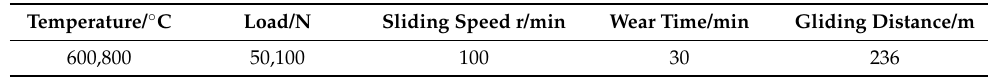
Figure 1. Schematic diagram of the set-up of the oxidation wear experiment. After testing, the samples were polished, subjected to pre-sliding friction for 5 min to ensure the close fit of the friction surface, and then placed in alcohol for ultrasonic cleaning treatment. After drying, the original mean weight m 0 was collected by the average value taken from the 12-time accurate measurement using an electron balance, and the actual volume V 0 of the pre-sliding sample was also obtained by the drainage method [40]. There- after, the pre-sliding pin and disc samples mentioned above were carefully installed on the wear tester for the oxidation wear tests. After the tests, the weight change m 1 was rec- orded to obtain the weight loss data. The weight losses of all tested samples under the given temperatures and loads were the average values of three homogeneous testing spec- imens. The wear test parameters are shown in Table 2. Table 2. High-temperature wear test parameters.